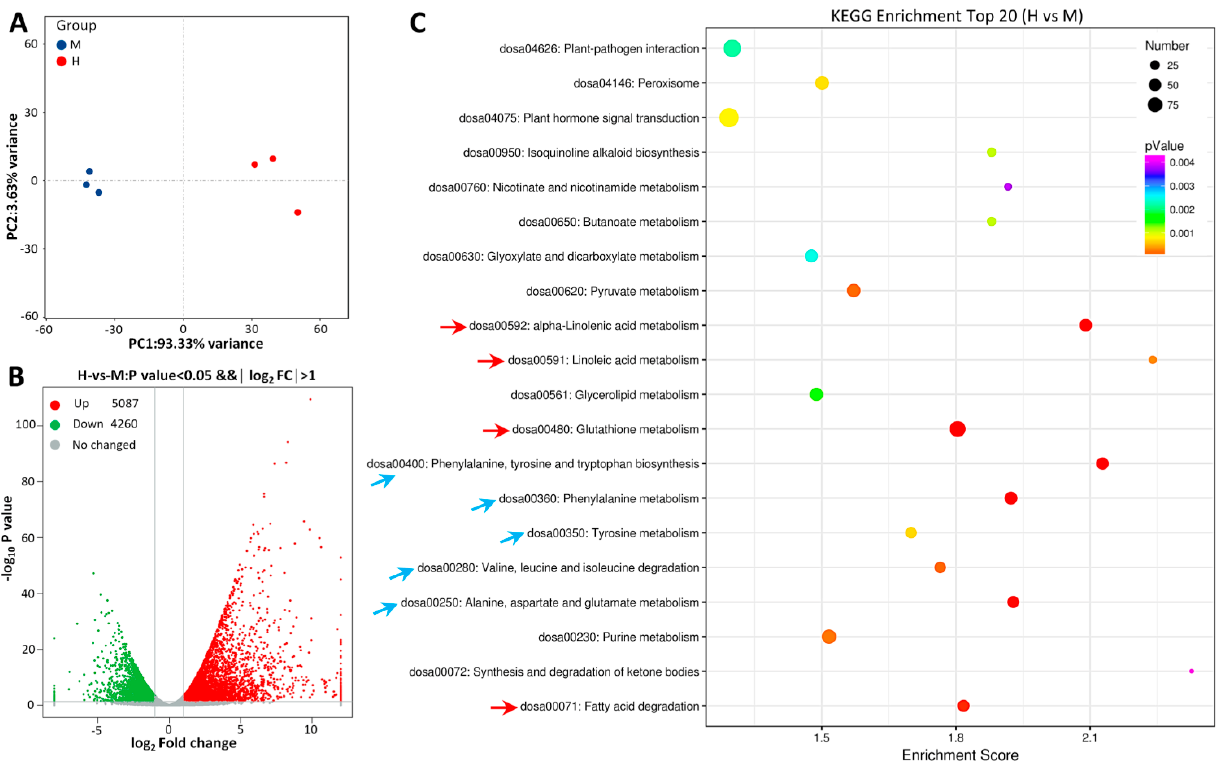
Figure 2. General overview of differentially expressed genes (DEGs). ( A ) PCA diagram. Blue dots, MSA group; red dots, HSA group. X − axis and Y − axis indicate the first and second principal components (PC1 and PC2), respectively. Score plots of PC1 and PC2 show cohesion within groups and separation between the MSA and HSA group, respectively. ( B ) Volcano map of transcriptome genes for HSA vs. MSA. Red dots, upregulated genes; green dots, downregulated genes; gray dots, genes with no significance. ( C ) KEGG enrichment of DEGs in TOP20 pathways. The p value is presented in a color scale, the size of the dots represents DEG number mapped in each pathway.